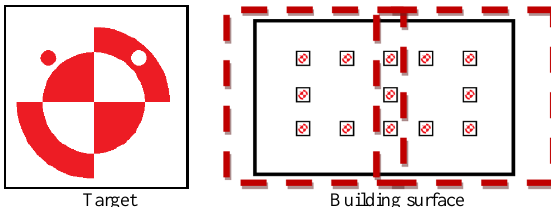
Figure 6. Paper target (a), organization of targets in succeeding partial photos